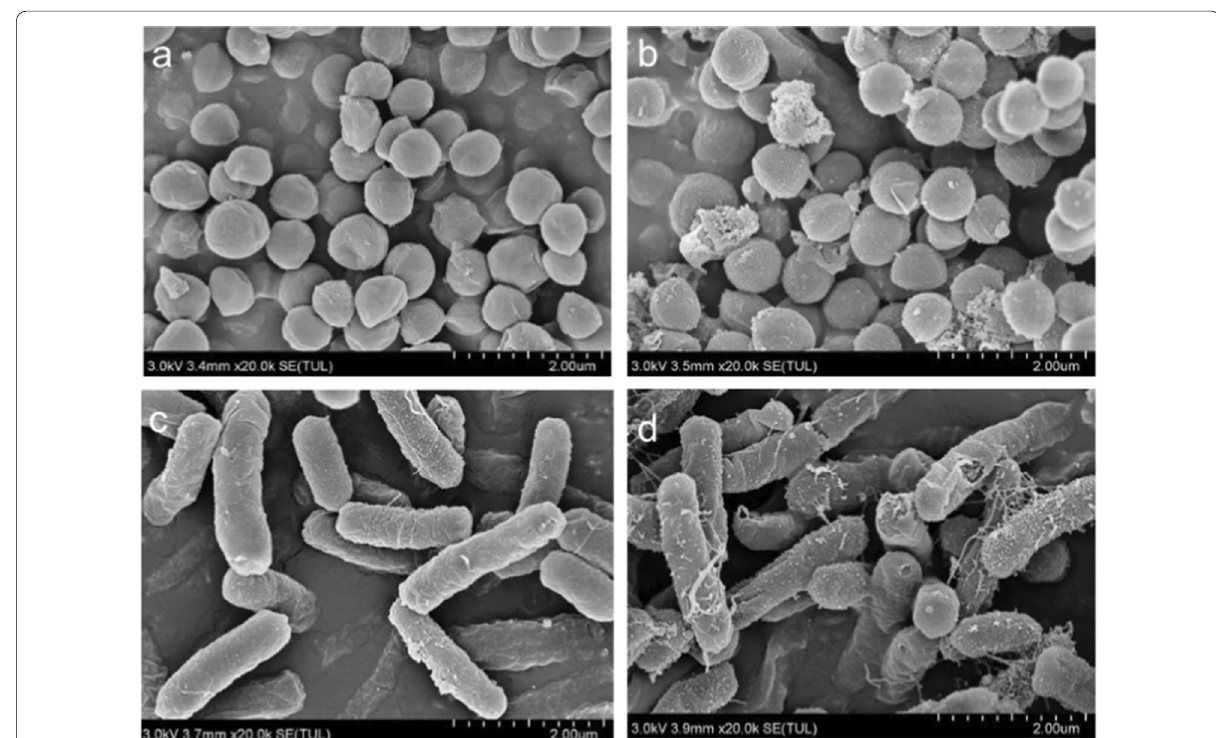
Fig. 8 SEM for S. aureus ( a , b ) and E.coli before ( a , c ) and after ( b , d ) the treatment with 30 µg/mL of CDFs. Scale bar: 2 µm